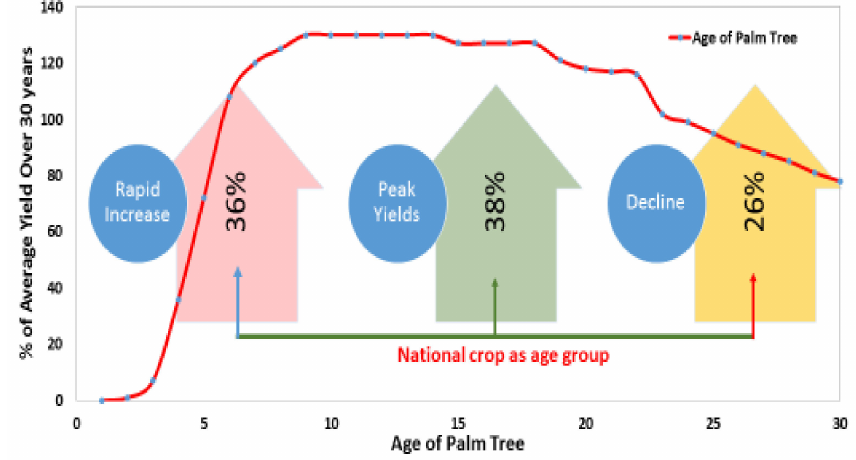
Figure 5. Ageing of palm oil